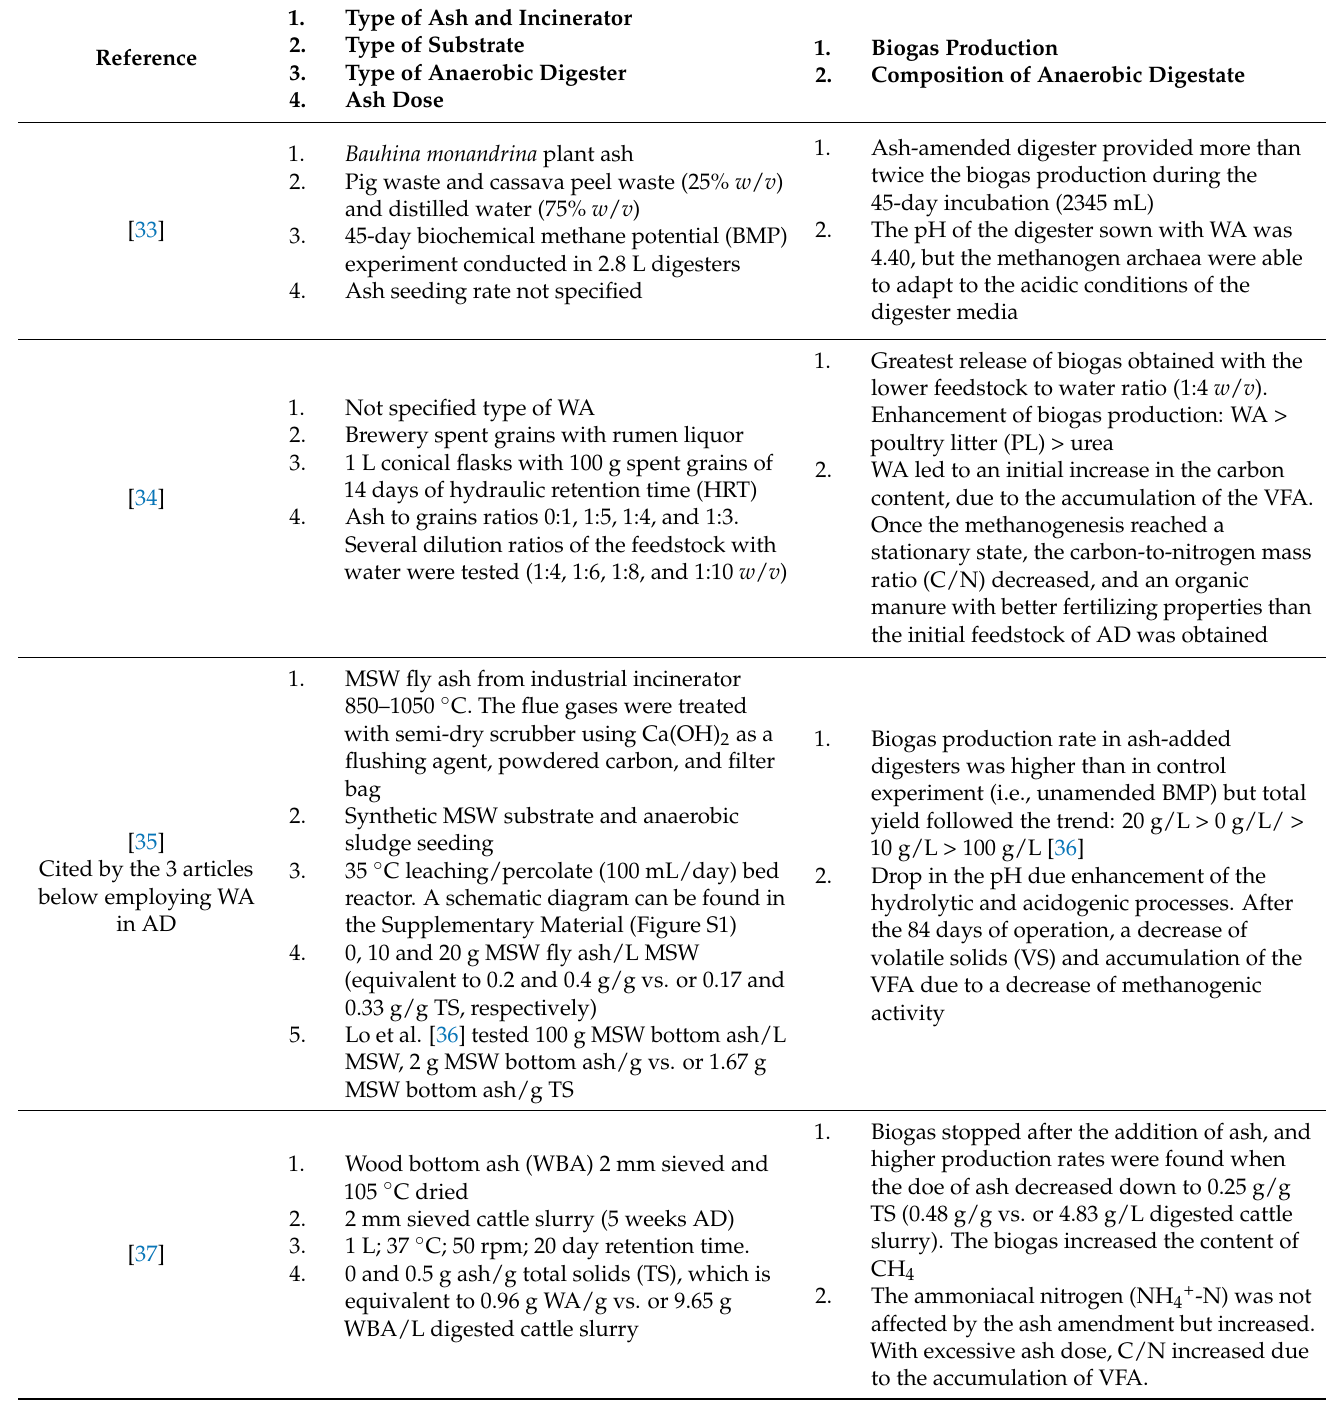
Table 1. Summary of the experimental studies on the use of WA in the